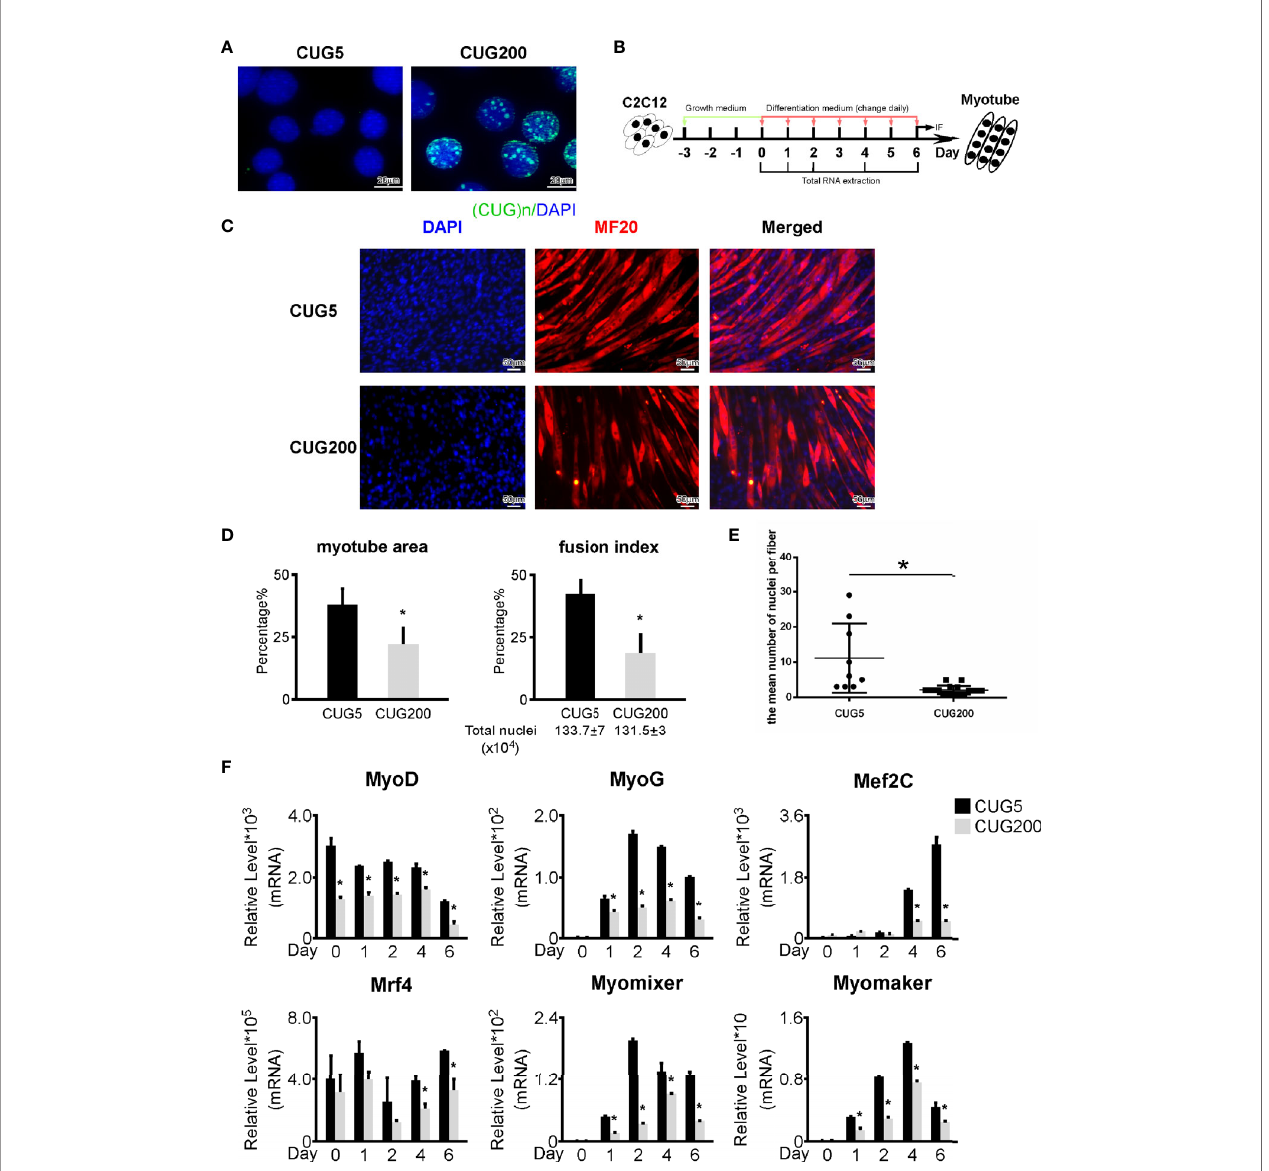
FIGURE 1 | Myogenesis was defective in the DM1 myoblast model. (A) Ribonuclear foci were detected in the DM1 myoblast model, but not in the normal group. RNA FISH with the (CAG)7 probe was performed on the normal and DM1 myoblast models. (B) Schematic diagram of in vitro myoblast differentiation of the normal and DM1 myoblasts. (C) Myotube formation was signi fi cantly repressed in the DM1 group. Immuno fl uorescence staining against MF20 was performed on differentiation day 6. (D) The myotube area and fusion index were signi fi cantly decreased in the DM1 group. (E) The mean number of nuclei per fi ber was signi fi cantly decreased in the DM1 group. (F) The expression of muscle regulatory factors (MyoD, MyoG, Mef2C, and Mrf4) and myoblast fusion genes (Myomixer and Myomaker) was signi fi cantly downregulated in the DM1 group. CUG5, the normal group; CUG200; the DM1 group; n ≥ 3; *p <